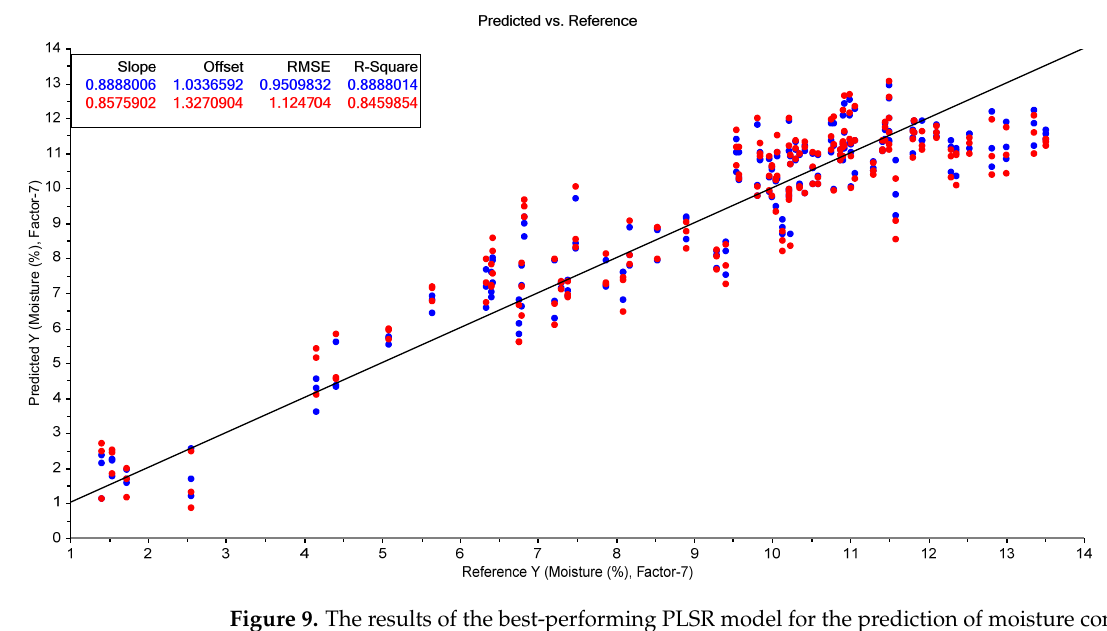
Figure 9. The results of the best-performing PLSR model for the prediction of moisture content using the FTIR spectra of the Regain samples (using SNV pre-processing). The blue points show the model calibration, while the red points show the model cross-validation.